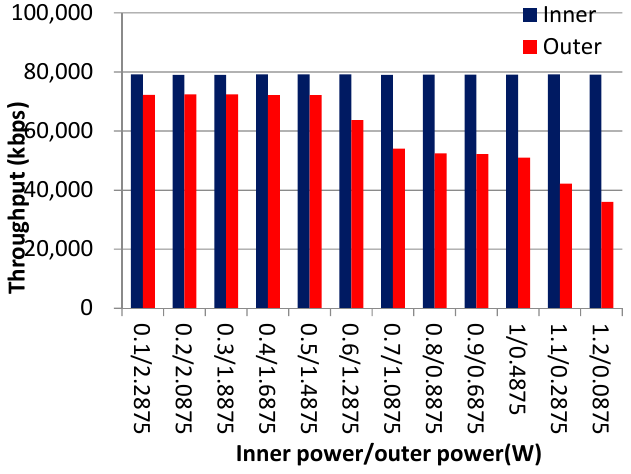
Figure 4. Power allocation VS. inner/outer area throughput.